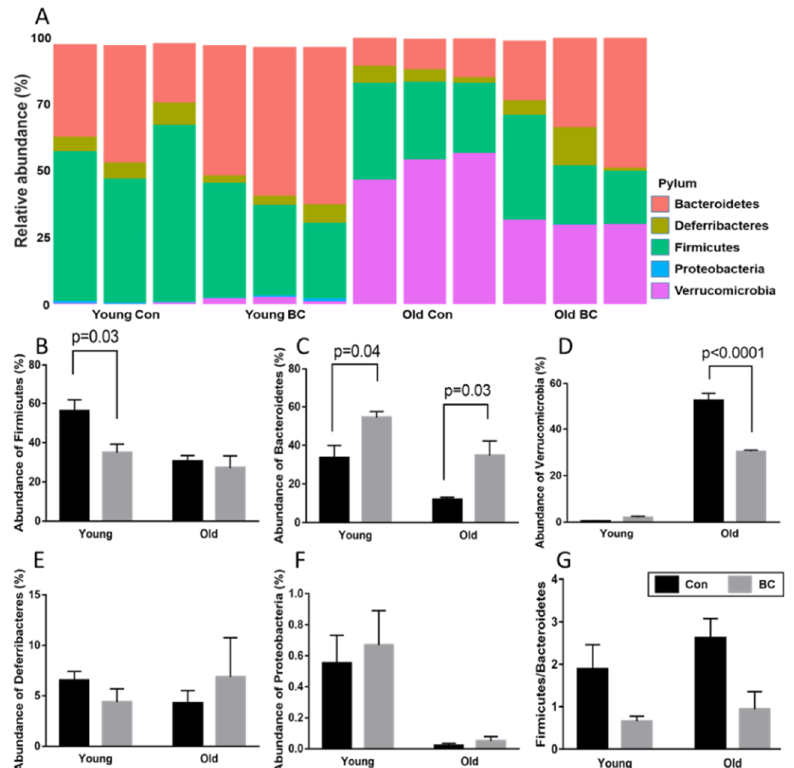
Figure 3. Phylum analysis of microbial samples with based on age and diet. ( A ) Composition of the six most abundant phyla in each sample. Relative abundance of individual phyla, including ( B ) Firmicutes, ( C ) Bacteroidetes, ( D ) Verrucomicrobia, ( E ) Deferribacteres, ( F ) Proteobacteria, ( G ) Ratio of fecal Firmicutes to Bacteroidetes in each group. Data are presented as mean ± SEM.